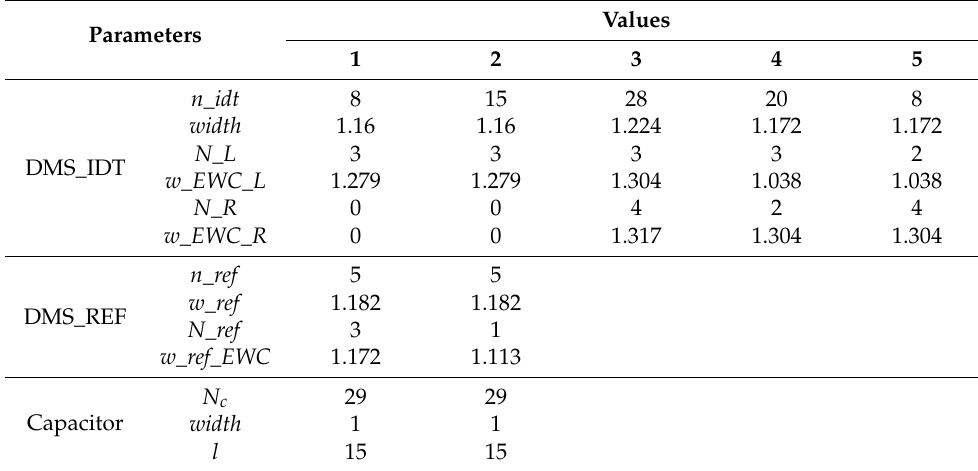
Table 1. The parameters of the branch.